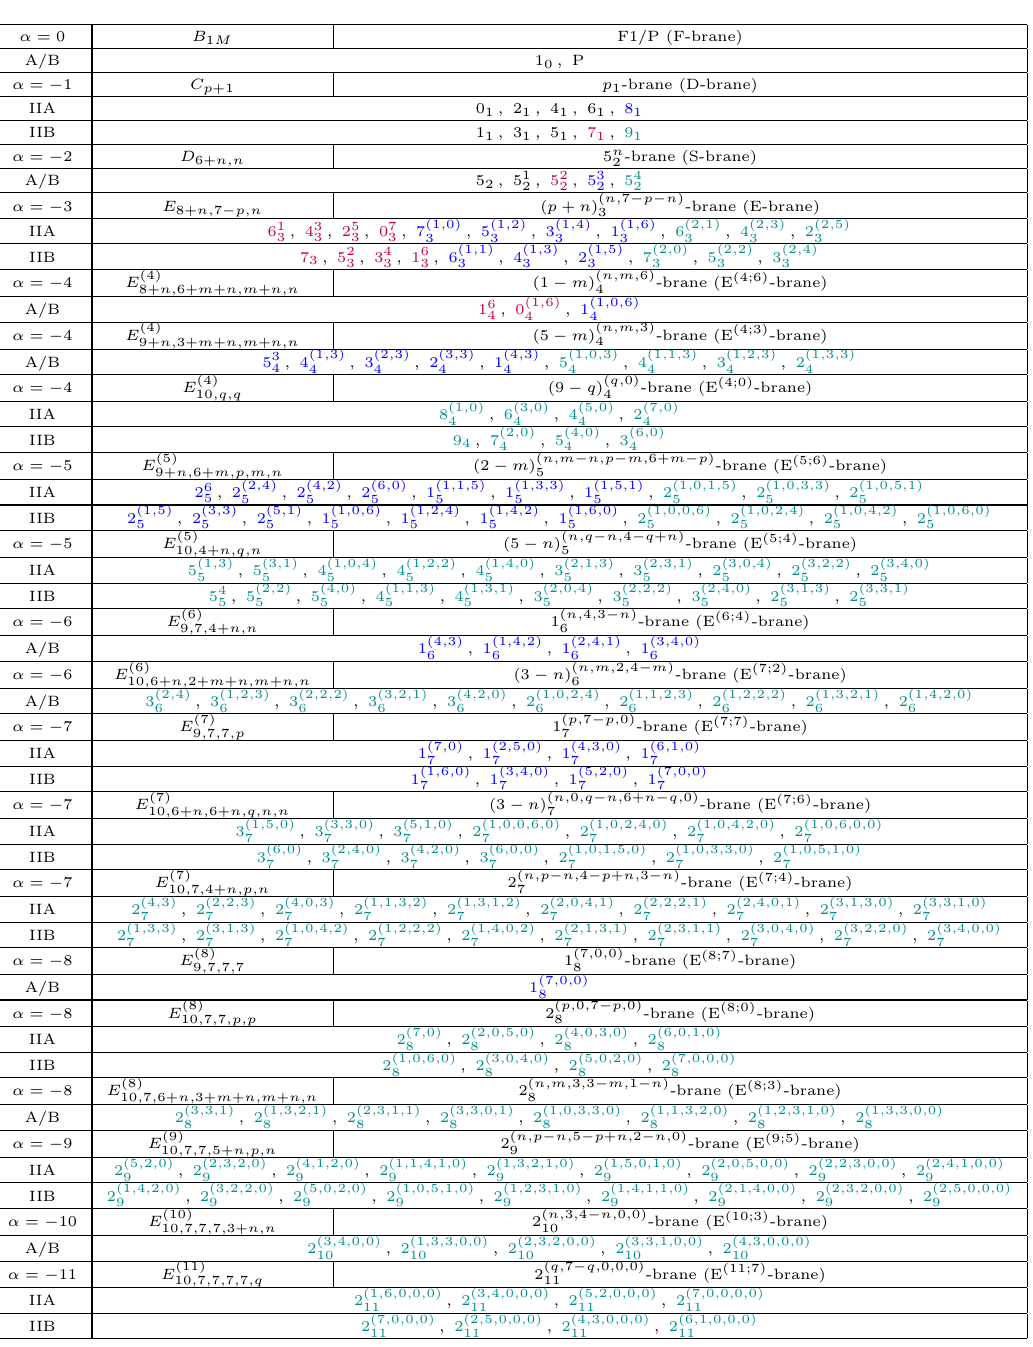
( α 3) and the corresponding s ≤ −